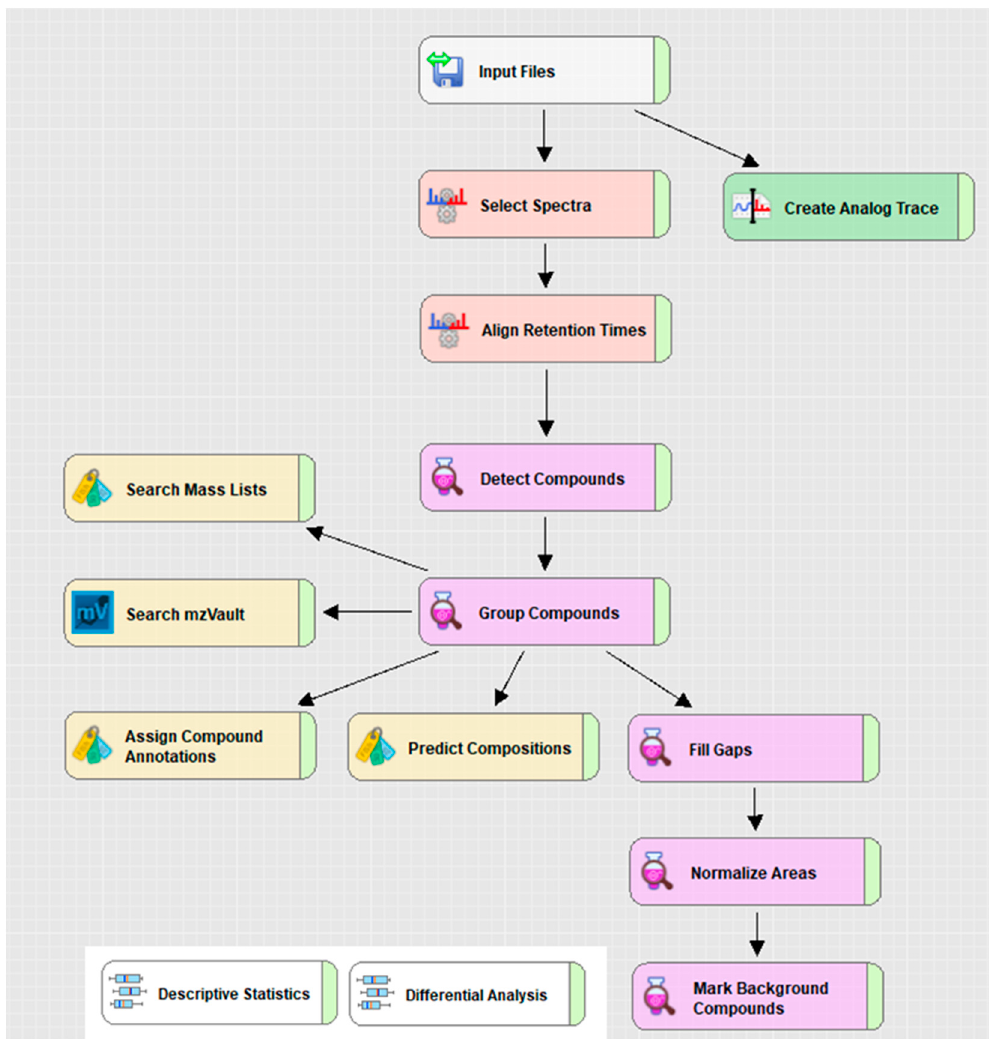
Figure A1. Compound Discoverer 3.1.0.305 workflow for the untargeted reversed-phase (RP) and hydrophilic interaction liquid chromatographic (HILIC-MS) analysis. Detailed parameters can be found here: www.ebi.ac.uk/metabolights/ MTBLS1782 (access on 8 March